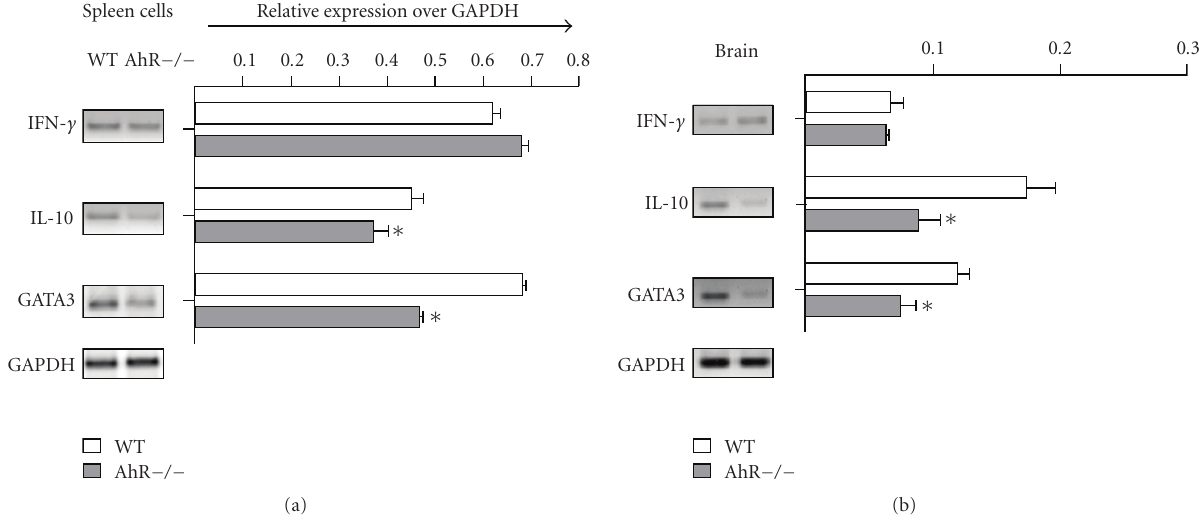
Figure 7: Gel electrophoresis on IFN- γ , IL-10, GATA-3, and GAPDH-amplified products. Total RNA was isolated from Splenocytes (a) or brain tissue (b) from WT and AhR-/- mice at 25 days after T gondii infection as described in Materials and Methods . The resulting fragments migrated along with the 200–500 bp fragment of the 100kb marker used. The exact fragment sizes are listed in Table 1.